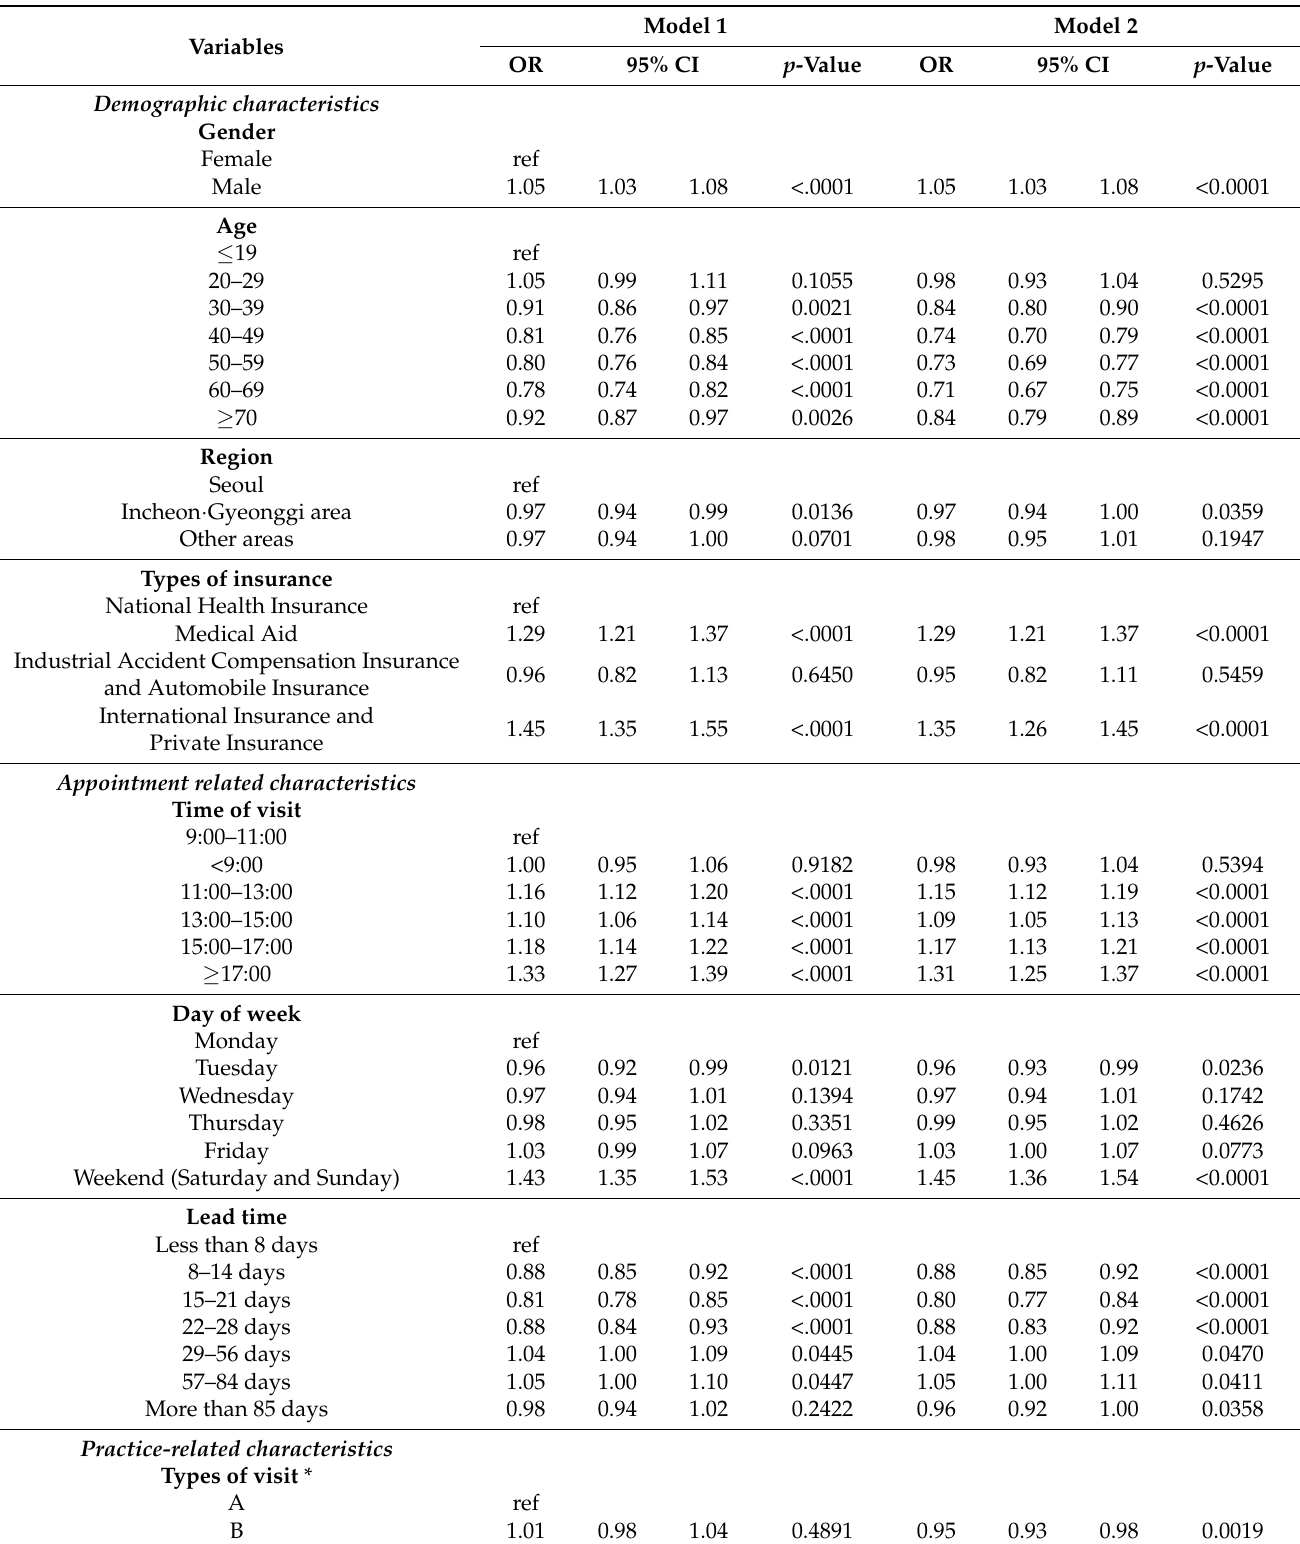
Table 2. Multivariate logistic regression identifying the factors associated with